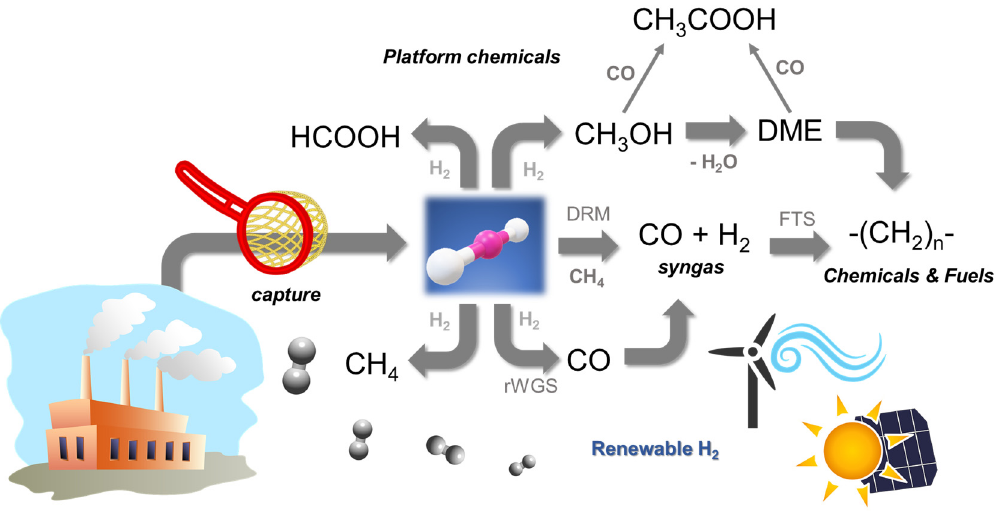
Figure 1. Schematic representation of CO 2 capture and possible utilisation routes.